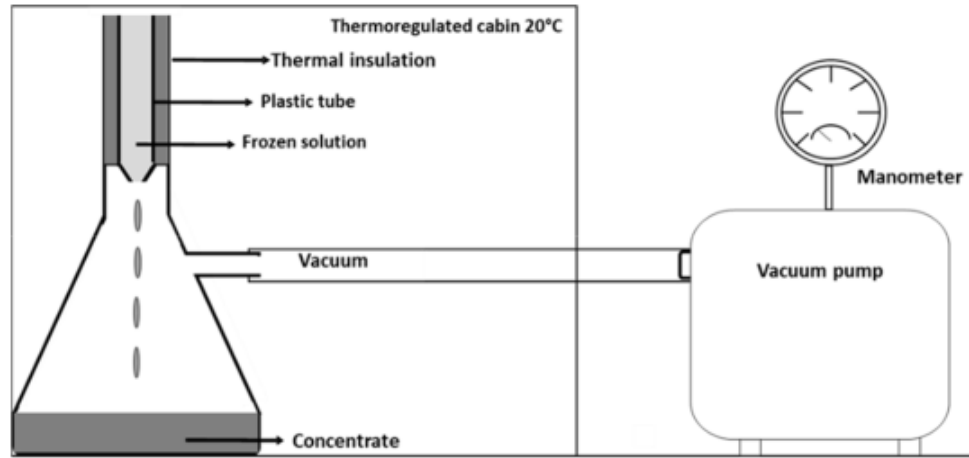
Figure 1. Vacuum unit for freeze